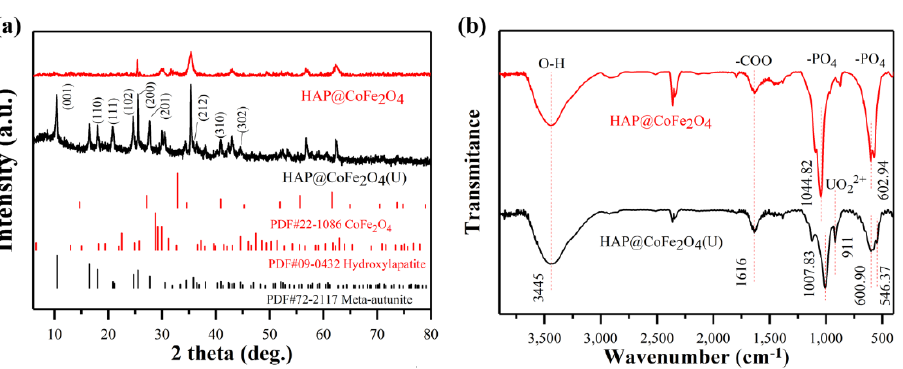
Figure 4. X-ray diffraction patterns ( a ) and FT-IR spectrum ( b ) of HAP@CoFe 2 O 4 and U(VI)-loaded HAP@CoFe 2 O 4 .